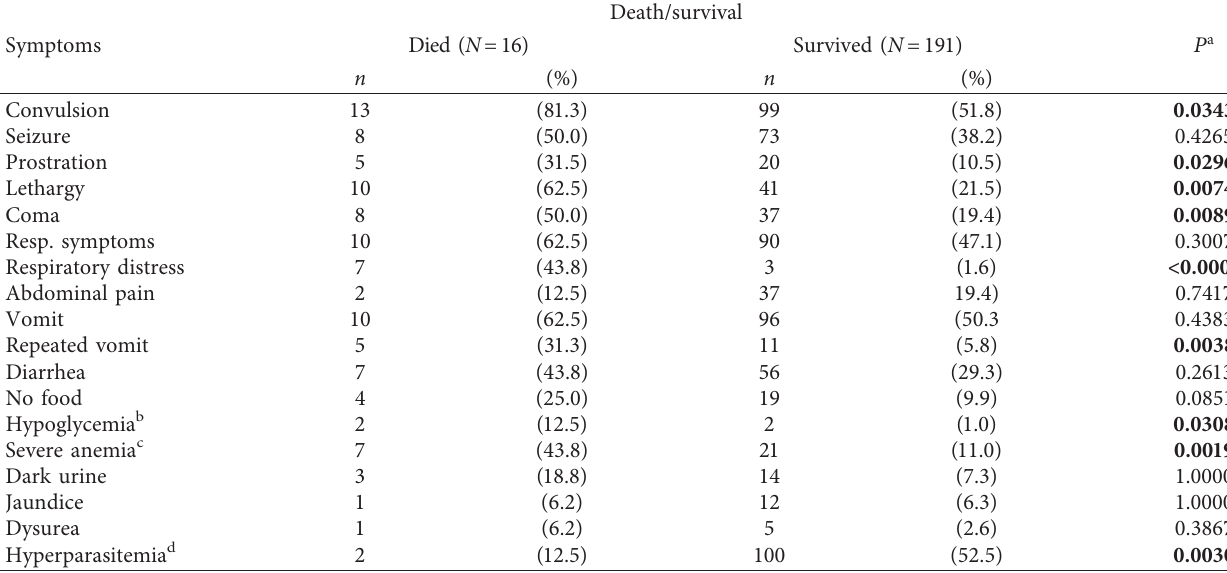
Table 1: Association of clinical symptoms with death and survival.